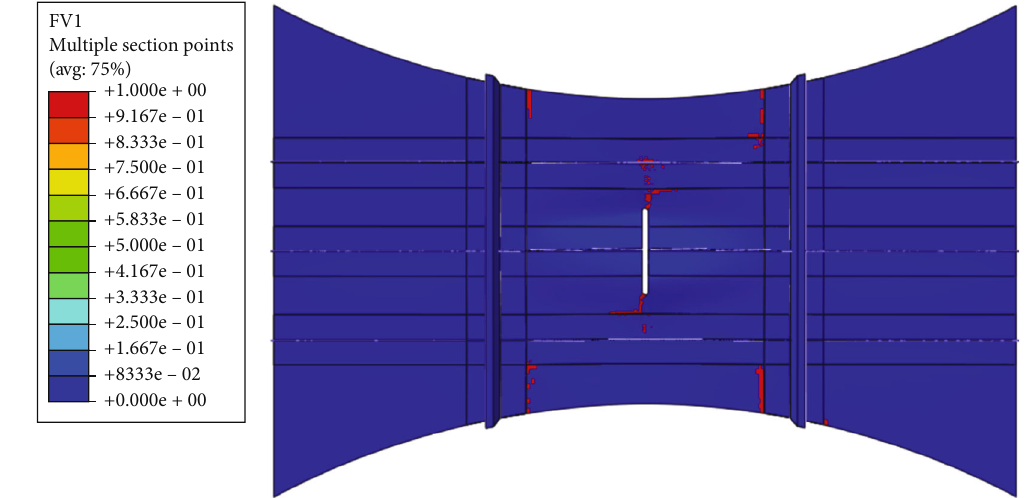
Figure 14: Evolution of tensile fi ber damage in three-stringer panel using Hashin failure criteria, implemented through USDFLD subroutine.